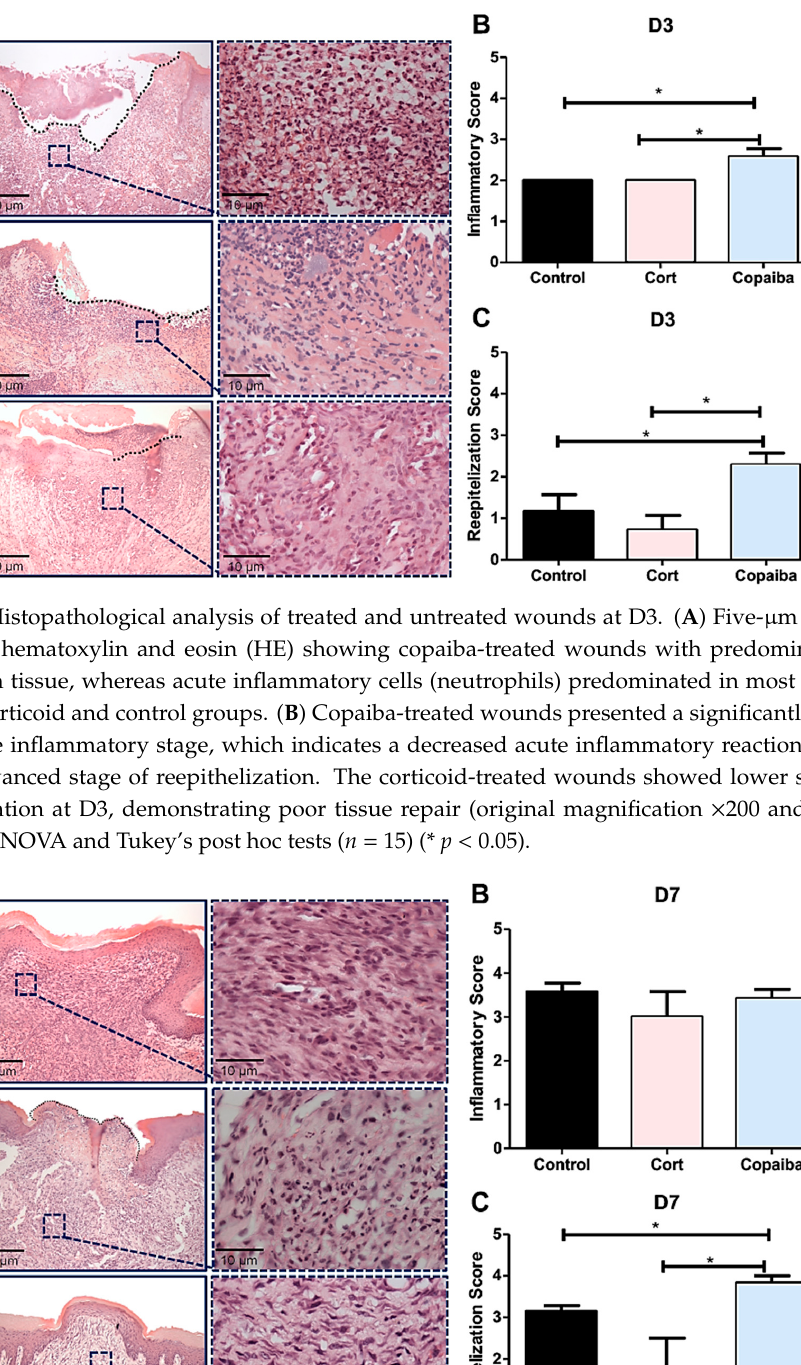
observed at an early time point when compared to corticoid-treated and control groups (Figure 2c). Acute inflammatory cells (neutrophils) predominated in most wounds from the corticoid and control group on this day (Figure 2a).